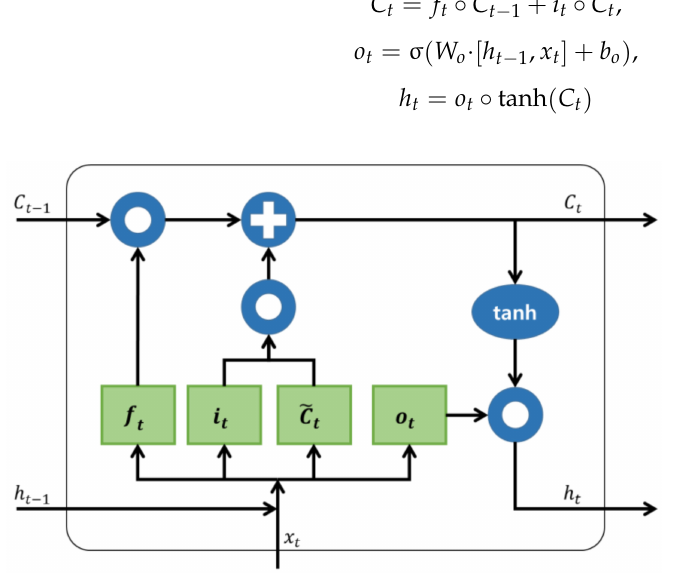
Figure 7. Cell operation process of LSTM.